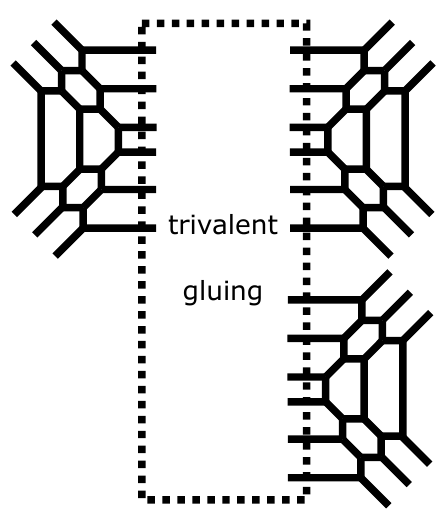
Figure 11. The web diagram for the theory (2.49), which is ( E 6 , E 6 ) 2 on S 1